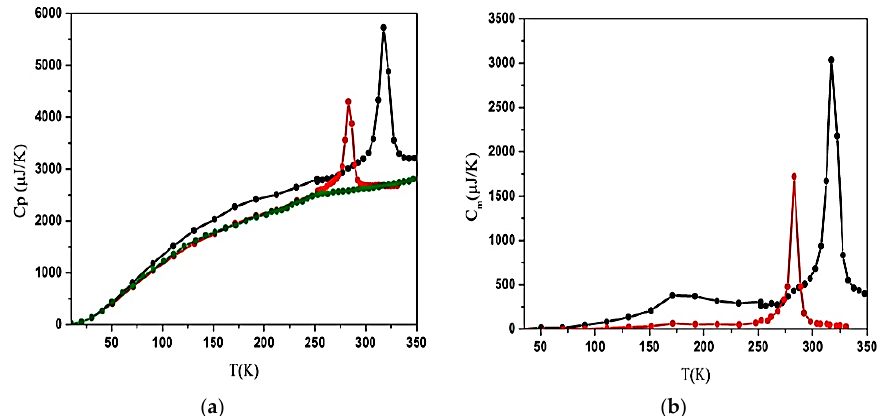
Figure 9. Specific heat measurements (here under zero-field) as performed on members of the series. Mn 2 − x Fe x P 1 − y Si y compared to a non-magnetic parent phosphide Co 2 P ( a ) for Co 2 P (green), Mn 1.30 Fe 0.70 P 0.30 Si 0.70 (red) , Mn 0.70 Fe 1.30 P 0.65 Si 0.35 (black) ( b ) after subtracting the Co 2 P contribution.